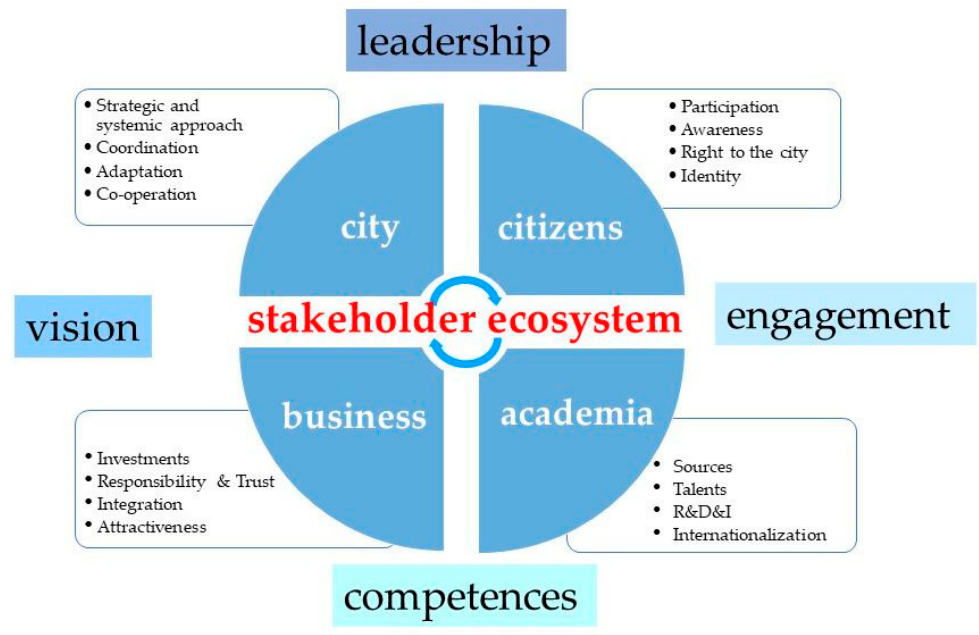
Figure 4. Stakeholders Ecosystem Model (SEM).